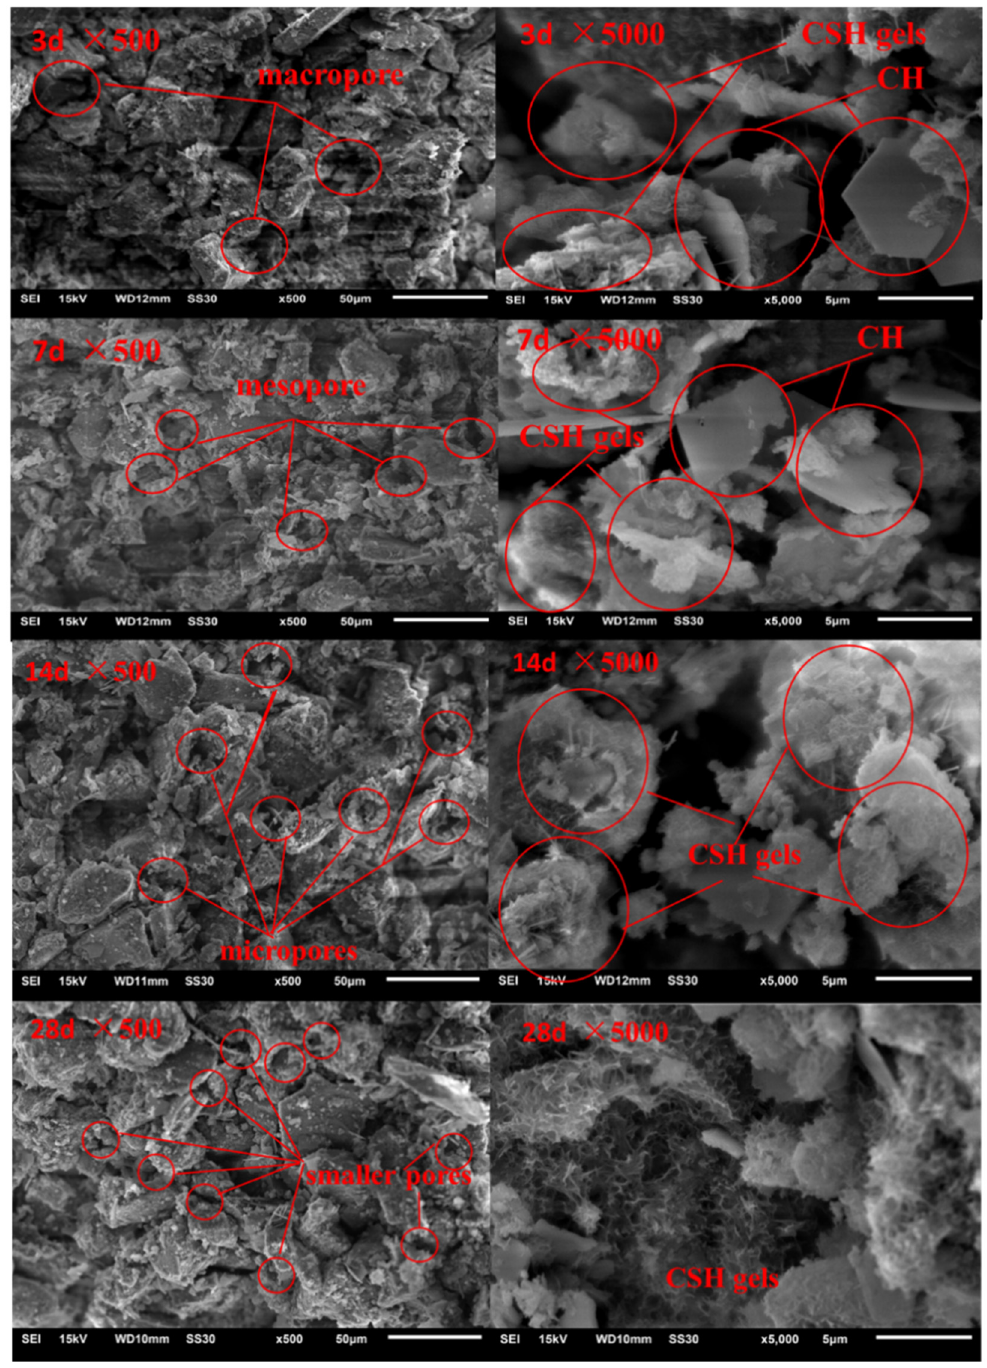
Figure 7. Microstructural characteristic evolutions of dredged soils stabilized by cement and steel slag at different curing ages.